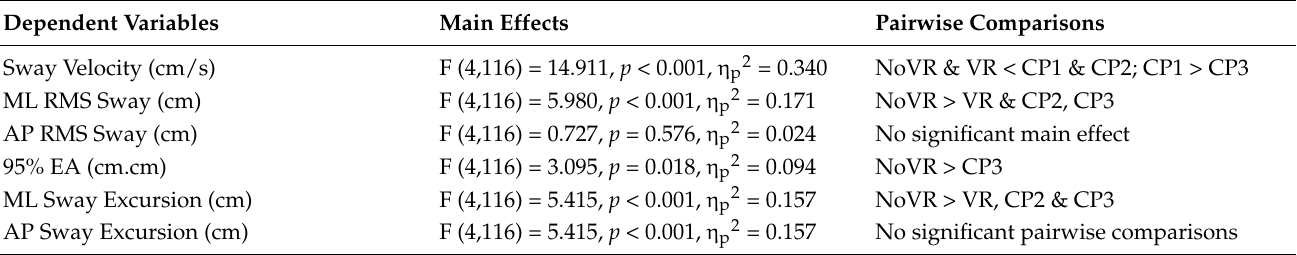
Table 1. Repeated measures ANOVA results for main effects and pairwise comparisons at p <